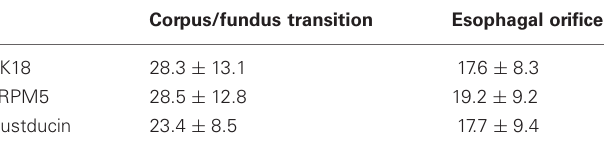
Table 1 | Percentage of immunoreactive cells underneath the “limiting ridge” at corpus/fundus transition and esophagal